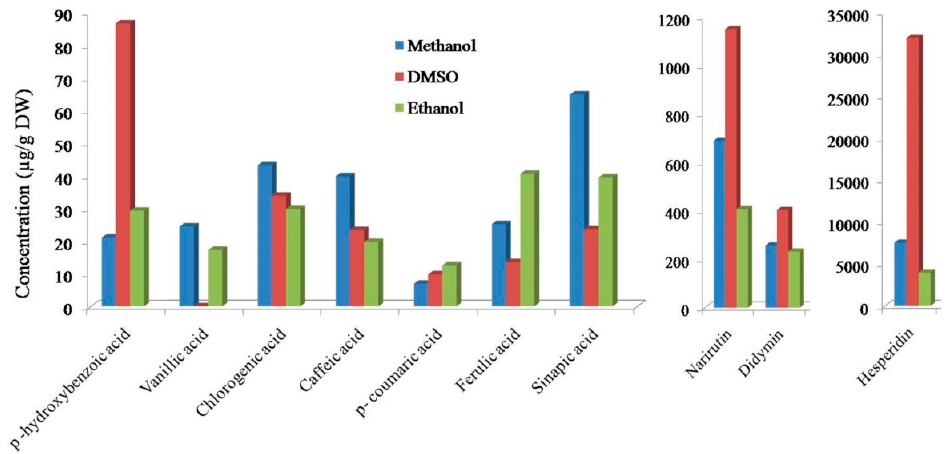
Figure 6. E ff ect of the nature of solvents on the yield of total phenolics by the solvent extraction process [58] .